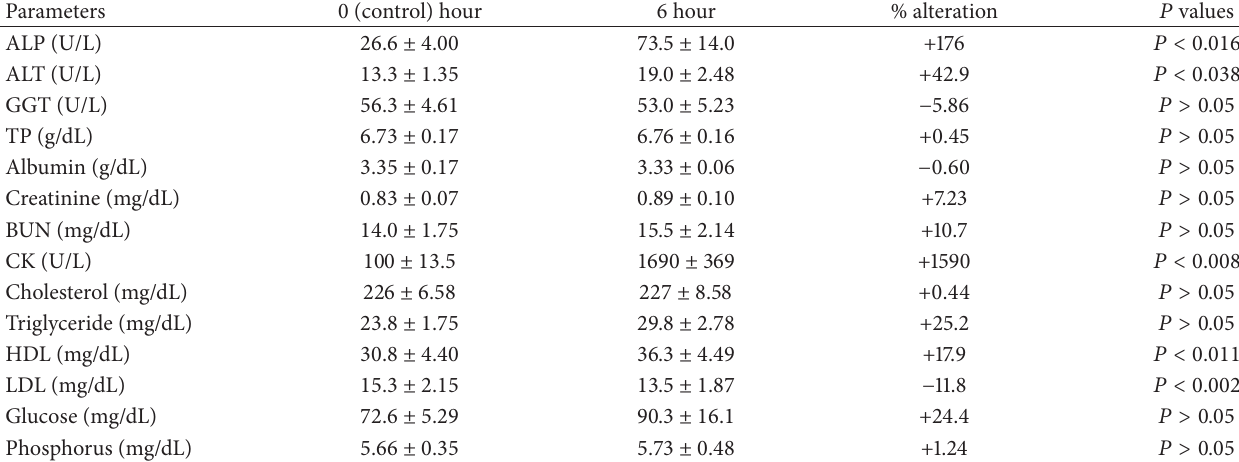
Table 2: The effect of diclofenac (2.5mg/kg, IM) treatment on the plasma concentrations of hepatic, renal, and muscular damage markers; lipid metabolism products; some biochemical parameters in rams (mean ± SEM).